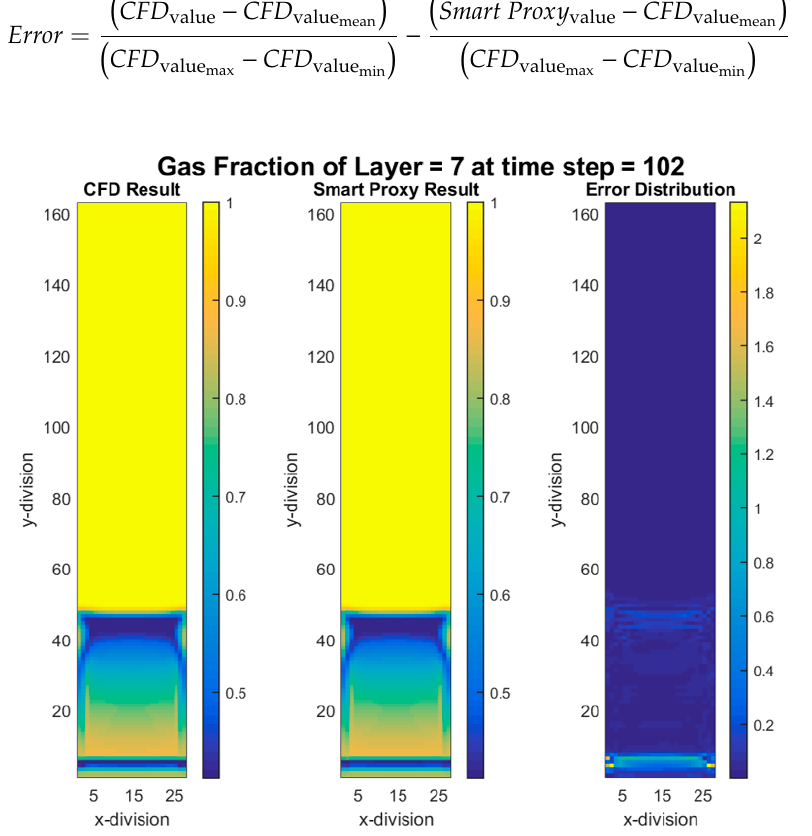
Figure 13. CFD and smart proxy results for gas volume fraction at K = 7 cross-sectional plane (time-step 102—early time).